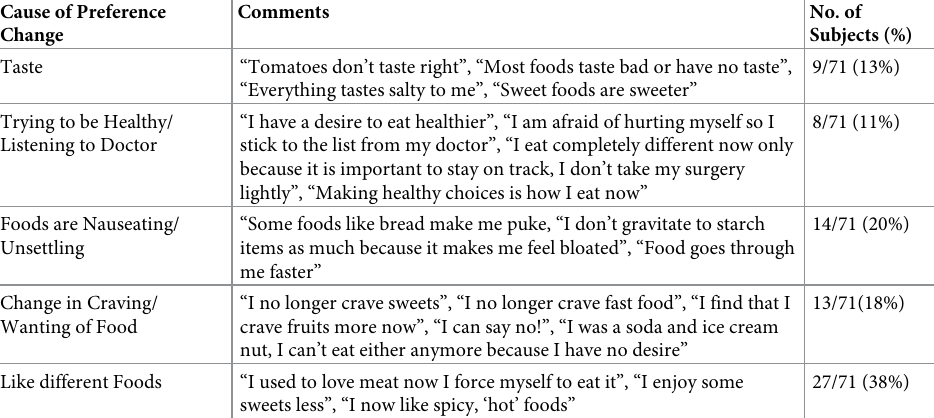
Table 1. Stated causes of subjects’ taste/food preference changes following RYGB